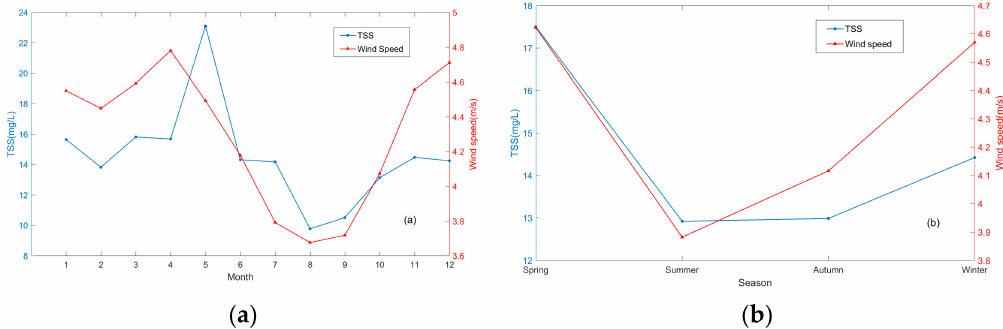
Figure 12. Comparison of monthly and seasonal average wind speed and TSSs: ( a ) is monthly result and ( b ) is seasonal